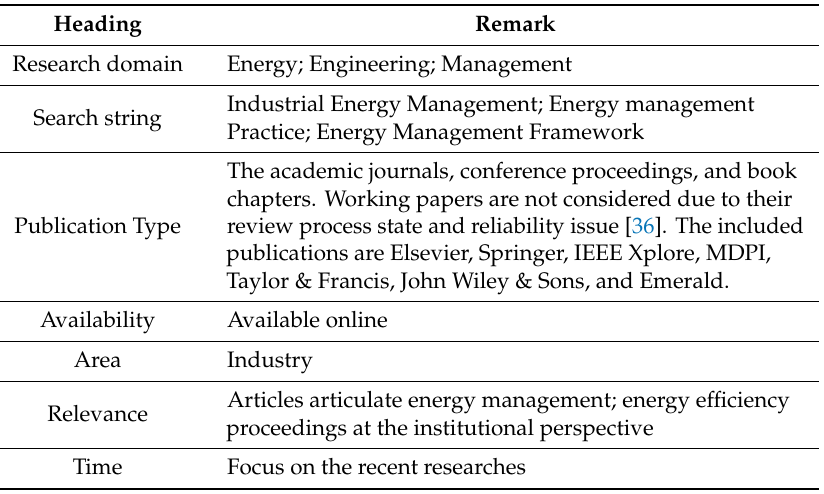
Table 1. Selection basis of the literature review.